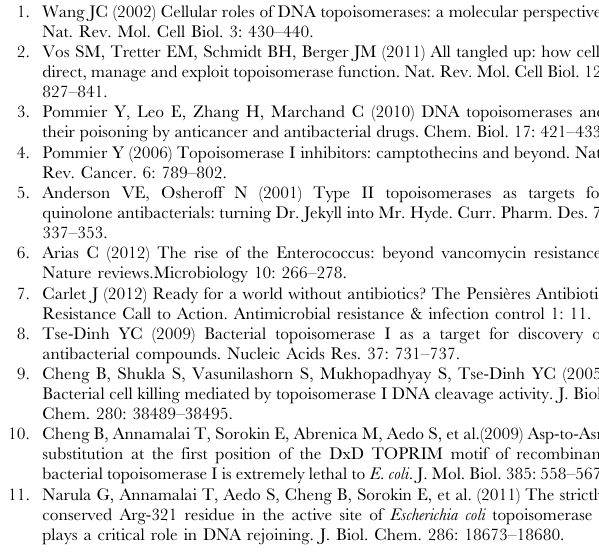
Figure S1 NMR spectra of anziaic acid. (a) 1 H NMR spectrum. (b) 13 C NMR spectrum. (c) COSY spectrum. (d) HSQC spectrum. (e) HMBC spectrum. (PDF) Figure S2 NMR data of anziaic acid. (PDF) Figure S3 MS spectrum of anziaic acid. (PDF) Table S1 13 C and 1 H spectral data for anziaic acid in CD 3 OD.